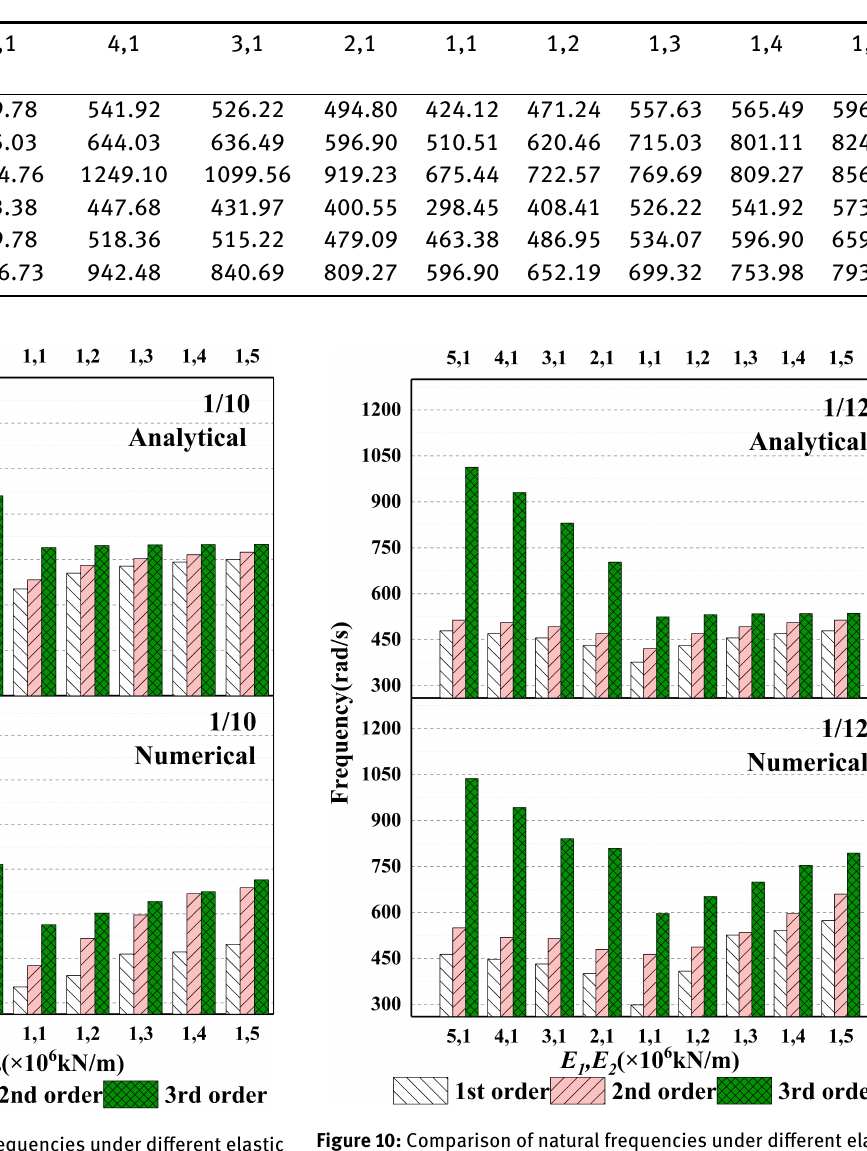
Figure 9: Comparison of natural frequencies under different elastic modulus ratios when the rise span ratio is 1/10